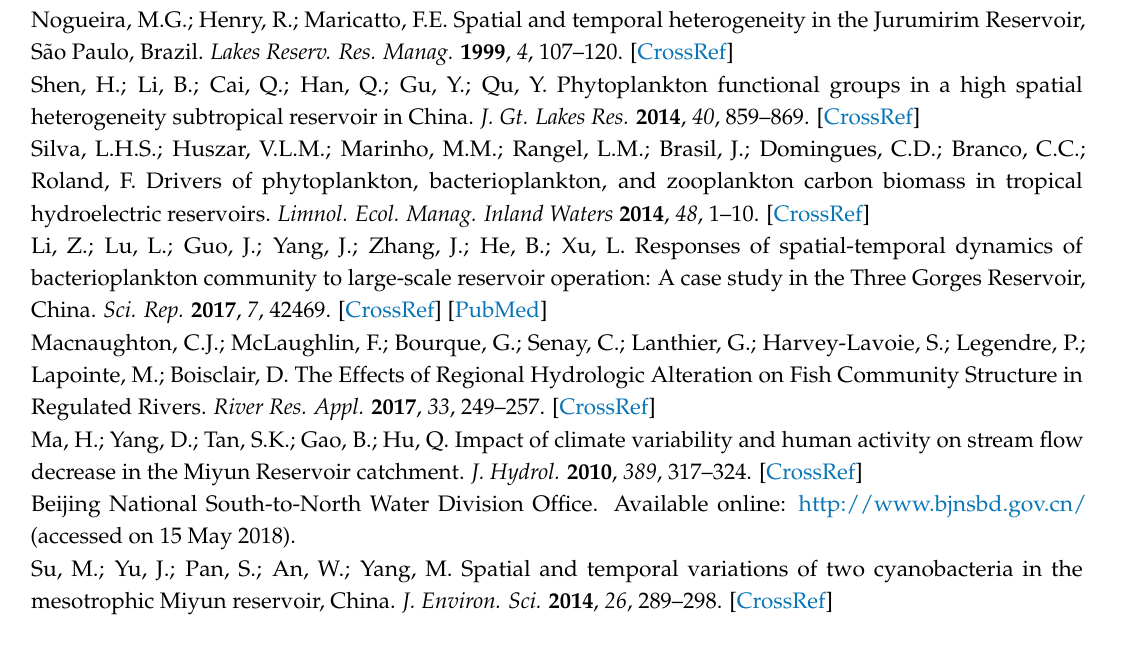
Table S1 Water quality analysis of samples collected from the Miyun Reservoir. Table S2 Richness and diversity indices used in this study. Figure S1 KEGG orthology (KO) involved in environmental sensing and xenobiotic biodegradation in Miyun